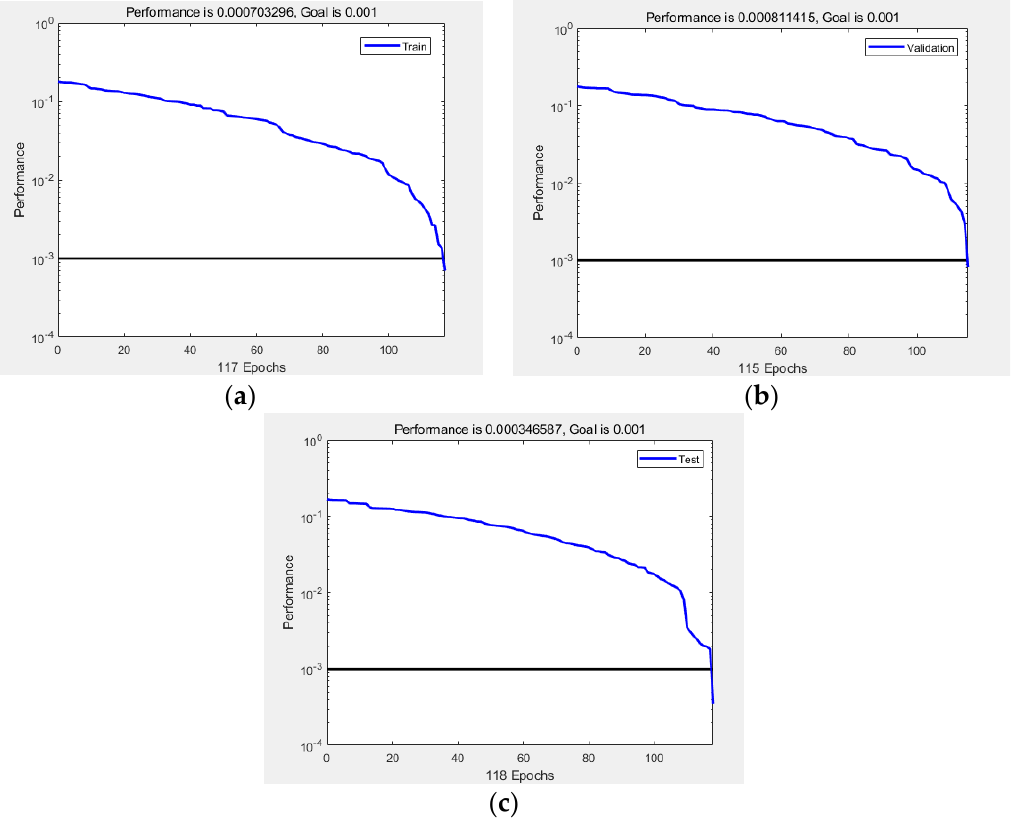
Figure 7. The performance of RBFNN. ( a ) Training stage; ( b ) validation stage; ( c ) testing stage.